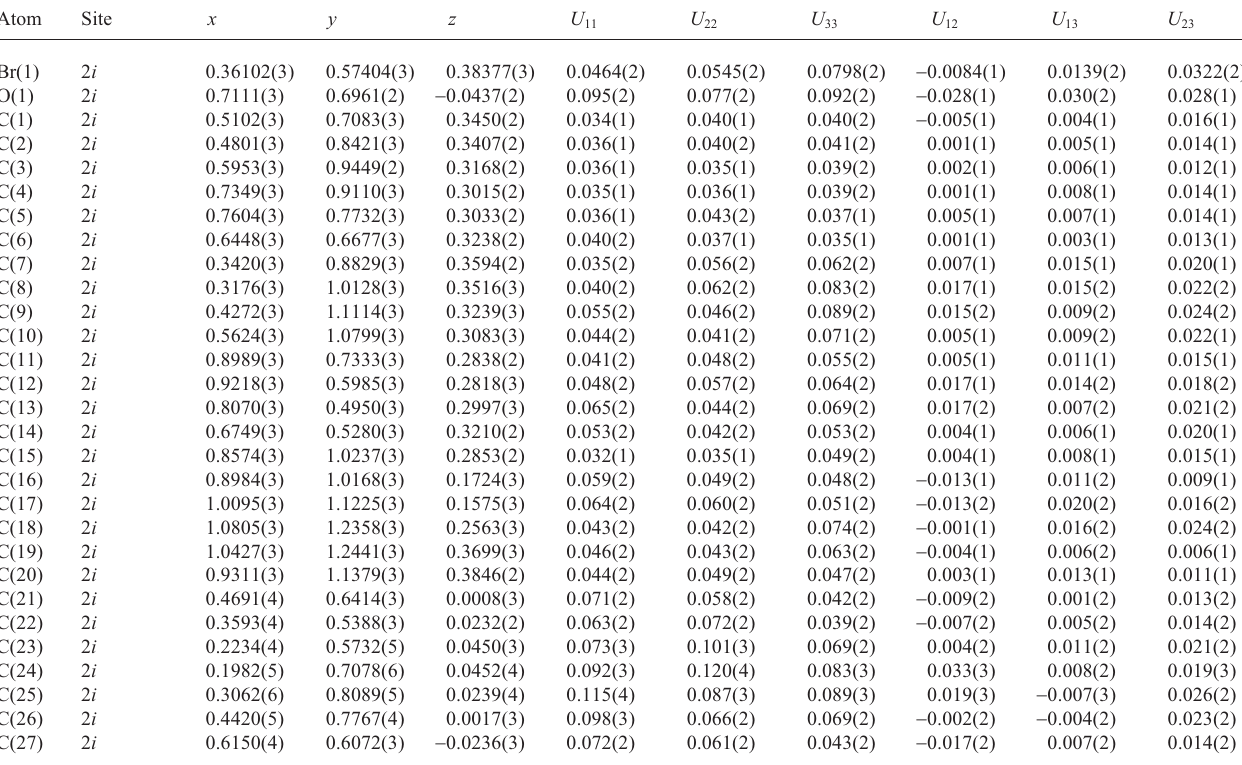
Table 3. Atomic coordinates and displacement parameters (in Å 2 )